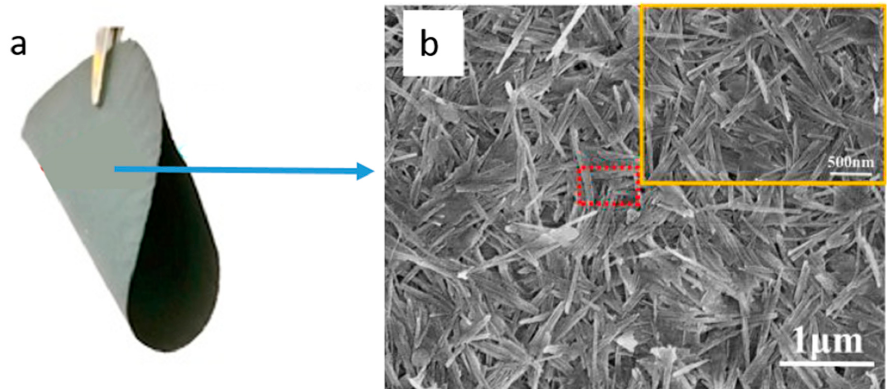
Figure 3. ( a ) Flexible attapulgite membranes; ( b ) SEM image of the membrane surface. Flexible membranes have been fabricated using fibrous attapulgite clay and sintering-free method (adapted from ref. [51] with permission from Elsevier).